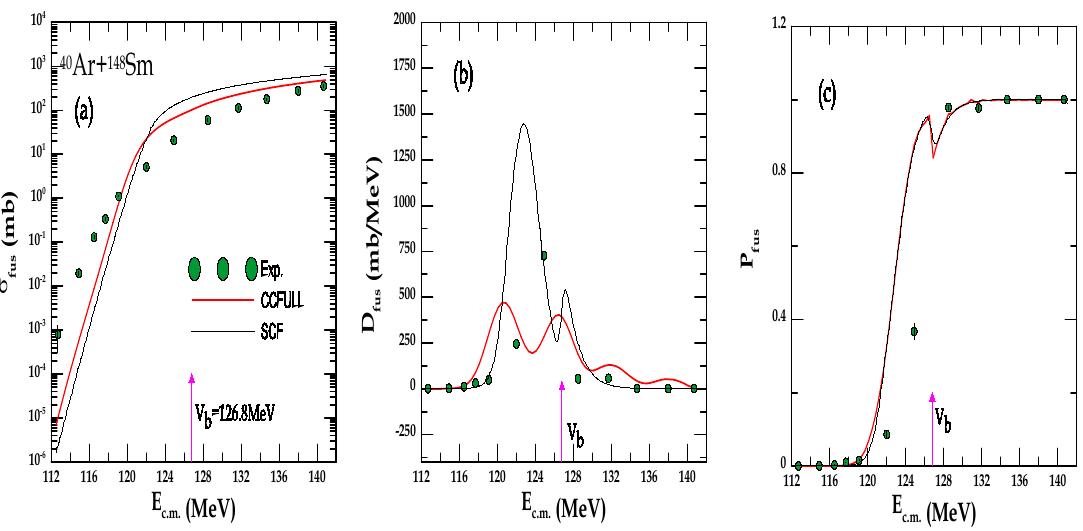
Fig.3: (a) The cross section of fusion, (b) the distribution of fusion barrier and (c) the probability of fusion for the system 40 Ar+ 148 Sm (red curve represent the quantum mechanical calculations, s black curve represents the semi-classical calculations, green circles are experimental data [21], the barrier position indicated by magenta arrow on the E c.m